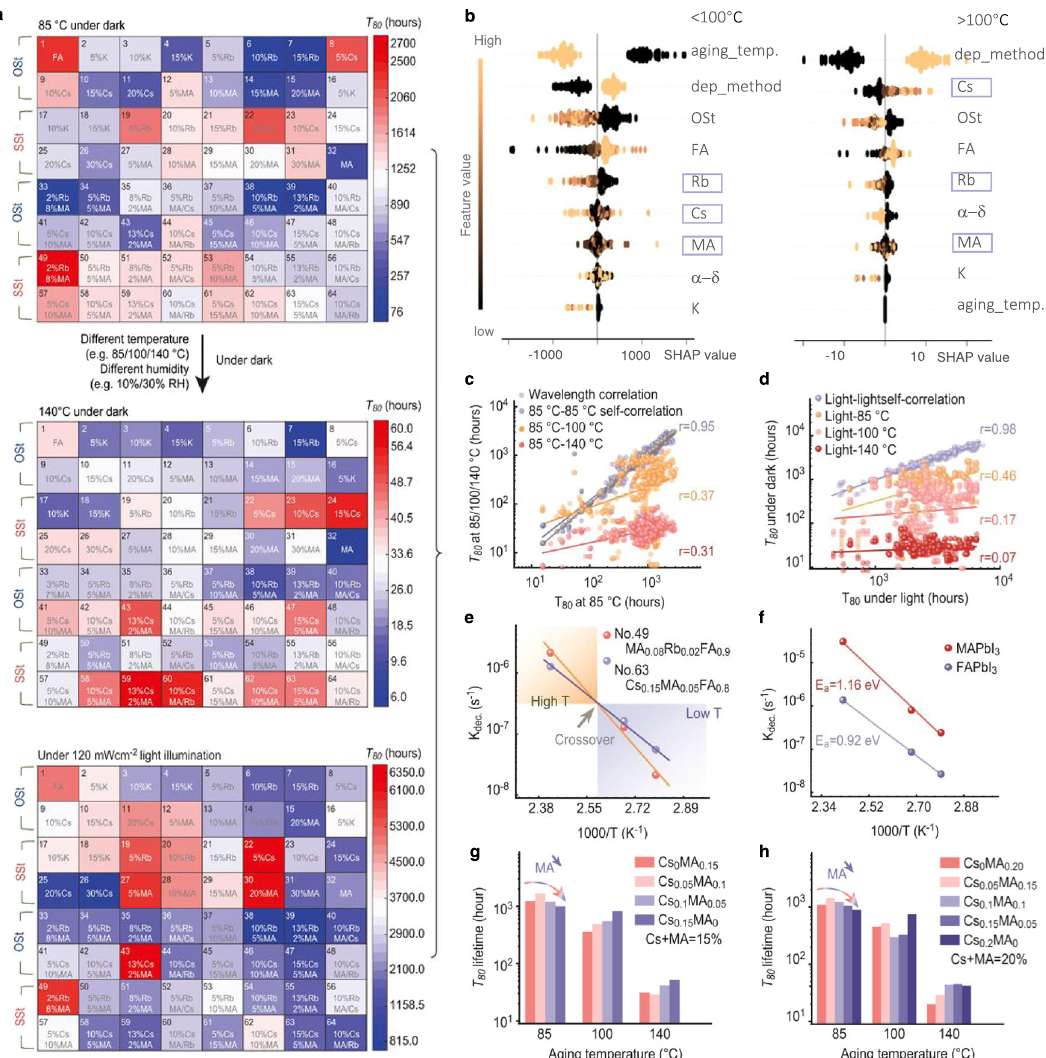
Fig. 2 Lifetime analysis of the 64 compositions for mixed-cation lead iodide perovskites. a The colormap of T 80 lifetime for the 64 perovskites aged in climate chambers preset at 85 °C (top) and 140 °C (middle) with 10% RH in the dark, and under 120 mW cm − 2 metal-halide light illumination with N 2 fl ow at 60 °C (bottom). b The ranking of feature importance using GBT regression and SHAP assessment, showing the impact of each cation and processing condition in descending order of importance (rank). The purple and orange color indicates low and high values of a given feature, respectively. Note that aging_temp., dep_method, Ost, α − δ indicates aging temperature, deposition method (drop-cast = 1), over-stoichiometric with excess iodide (OSt), the probability of phase transition in humid air (>30%RH), respectively. c The correlation plot of T 80 at 85 °C against T 80 at 85 °C, 100 °C, and 140 °C. Linear fi tting was used to fi t all the statistical data to obtain the Pearson correlation coef fi cients. d The correlation plot of T T 80 under light illumination against 80 aged at 85 °C, 100 °C, and 140 °C. e k dec -1000/T plot of No. 49 (MA 0.08 Rb 0.02 FA 0.9 PbI 3 ) and No. 63 (Cs 0.15 MA 0.05 FA 0.9 PbI 3 ). The data are fi tted using Eq. (2), indicated by blue and red lines. f k -1000/T plot of MAPbI 3 and FAPbI 3 . g , h T 80 lifetime versus ageing temperature for a series dec